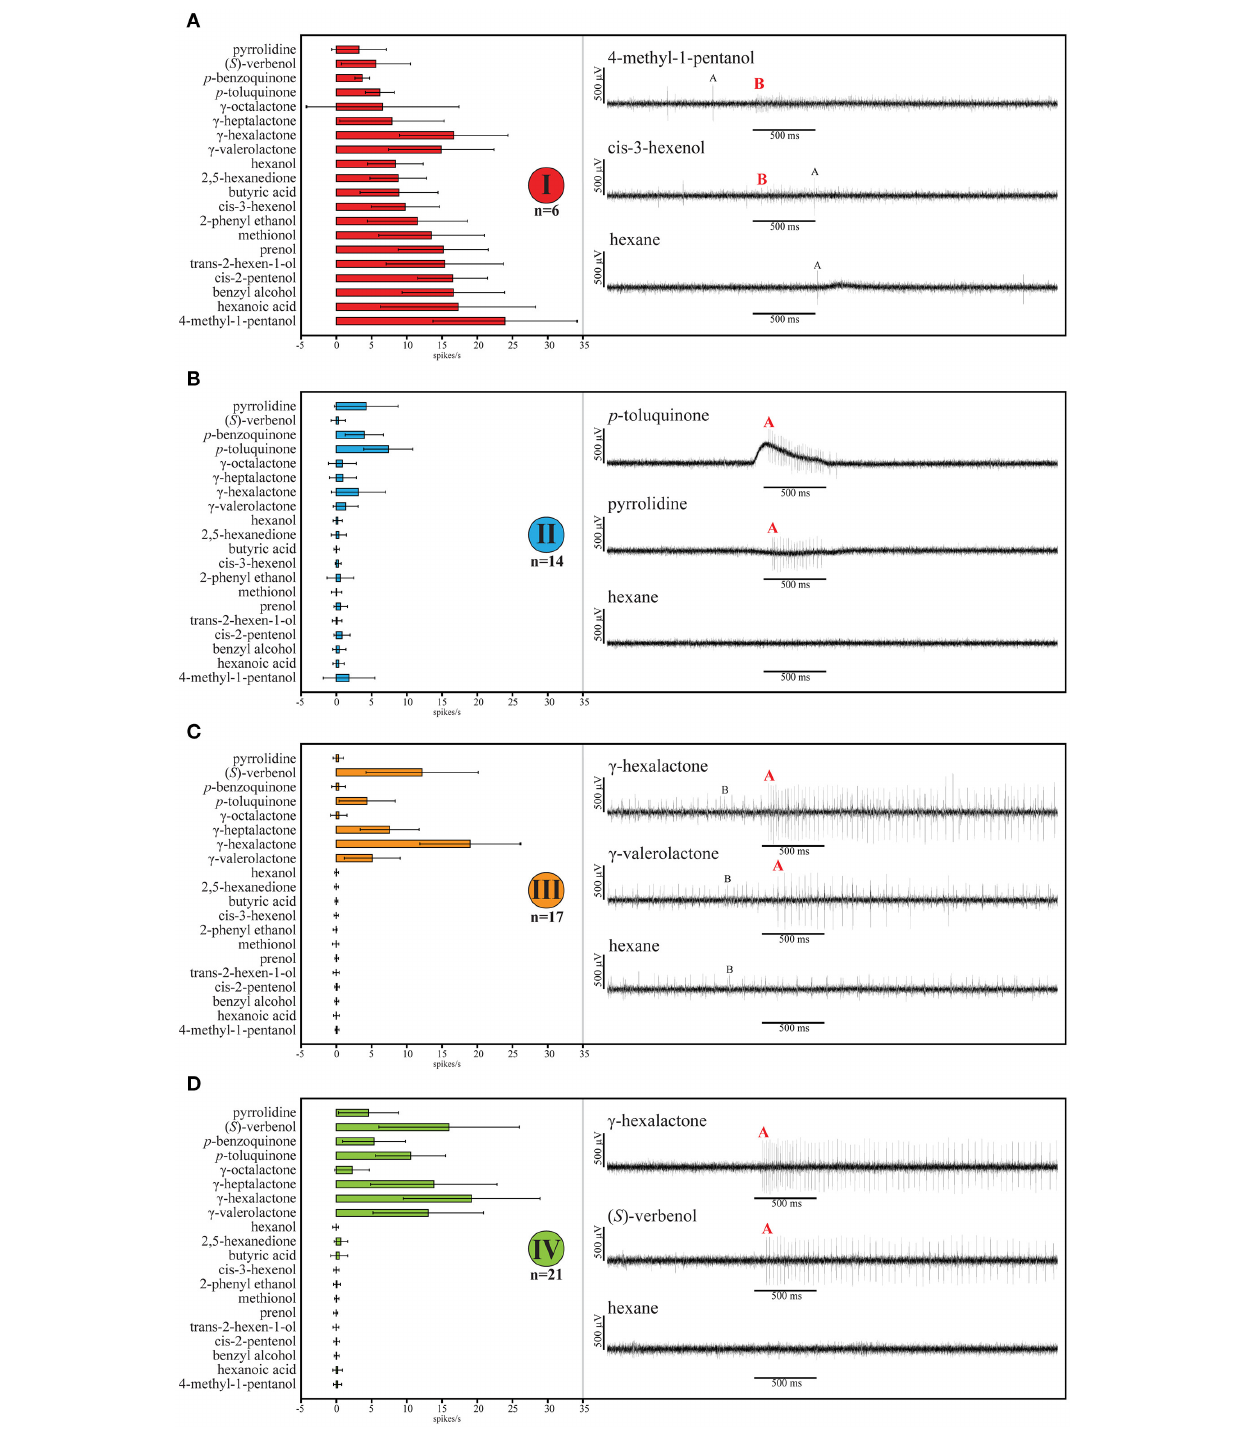
FIGURE 6 | Odor response spectra of the four functional OSN types with representative single sensillum recording (SSR) traces. Depicted single OSNs are marked in Figure 5 with colored dots. Reproduced are 20 representative odors eliciting responses in at least one of the four functional types of OSNs. (A) The first type responds to odorants of several chemical classes. The recorded ovipositor sensillum housed two OSNs, A (larger spike amplitude) and B (smaller spike amplitude). Only B-neurons with small spike amplitude clustered into this type. Stimulation with 4-methyl-1-pentanol elicits strong and sustained responses in the B-neuron whereas the A-neuron did not respond to the stimulus. The B-neurons (small spike amplitude) responded to the GLV cis-3-hexenol whereas the A-neuron did not exhibit spiking activity. First and third trace of this type also appeared in Figure 4. (B) The second OSN type showed a more narrow response profile. In the